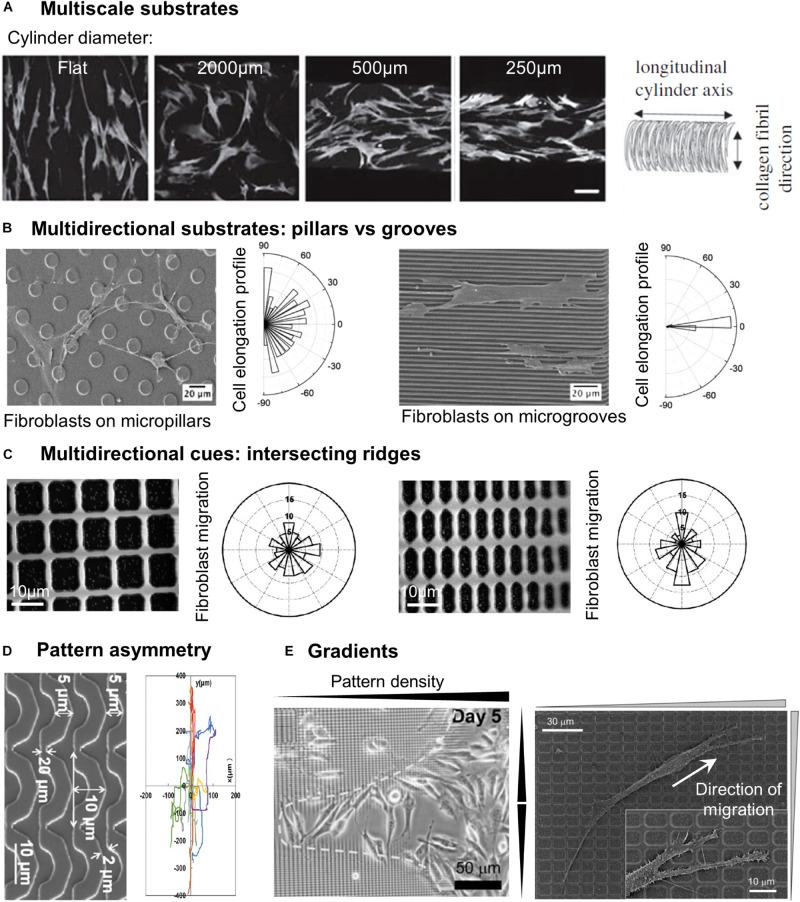
Cell response to different categories of microstructured substrates. (A) Human bone marrow stromal cells stained by F-actin on cylinders of different curvatures coated with anisotropically aligned collagen nanofibrils. Scale 100 μm. Reproduced with permission from Werner et al. (2018). (B) SEM images of fibroblasts on micropillars or microgrooves, associated with the cell elongation profile. Reprinted with permission from Ning et al. (2016). Copyright 2016 American Chemical Society. (C) Direction of fibroblast migration on a grid of intersecting ridges with different anisotropy. Reproduced with permission from Kim et al. (2009b). (D) Mouse osteoblastic cells migration tracks on substrates of arcs. Reproduced with permission from Tang et al. (2014). (E) Accumulation of fibroblasts in the center region of a gradient pattern with the highest density of structures (left). Close-up of a fibroblast migrating toward denser regions of the pattern (right). Reproduced with permission from Kim et al. (2009b).